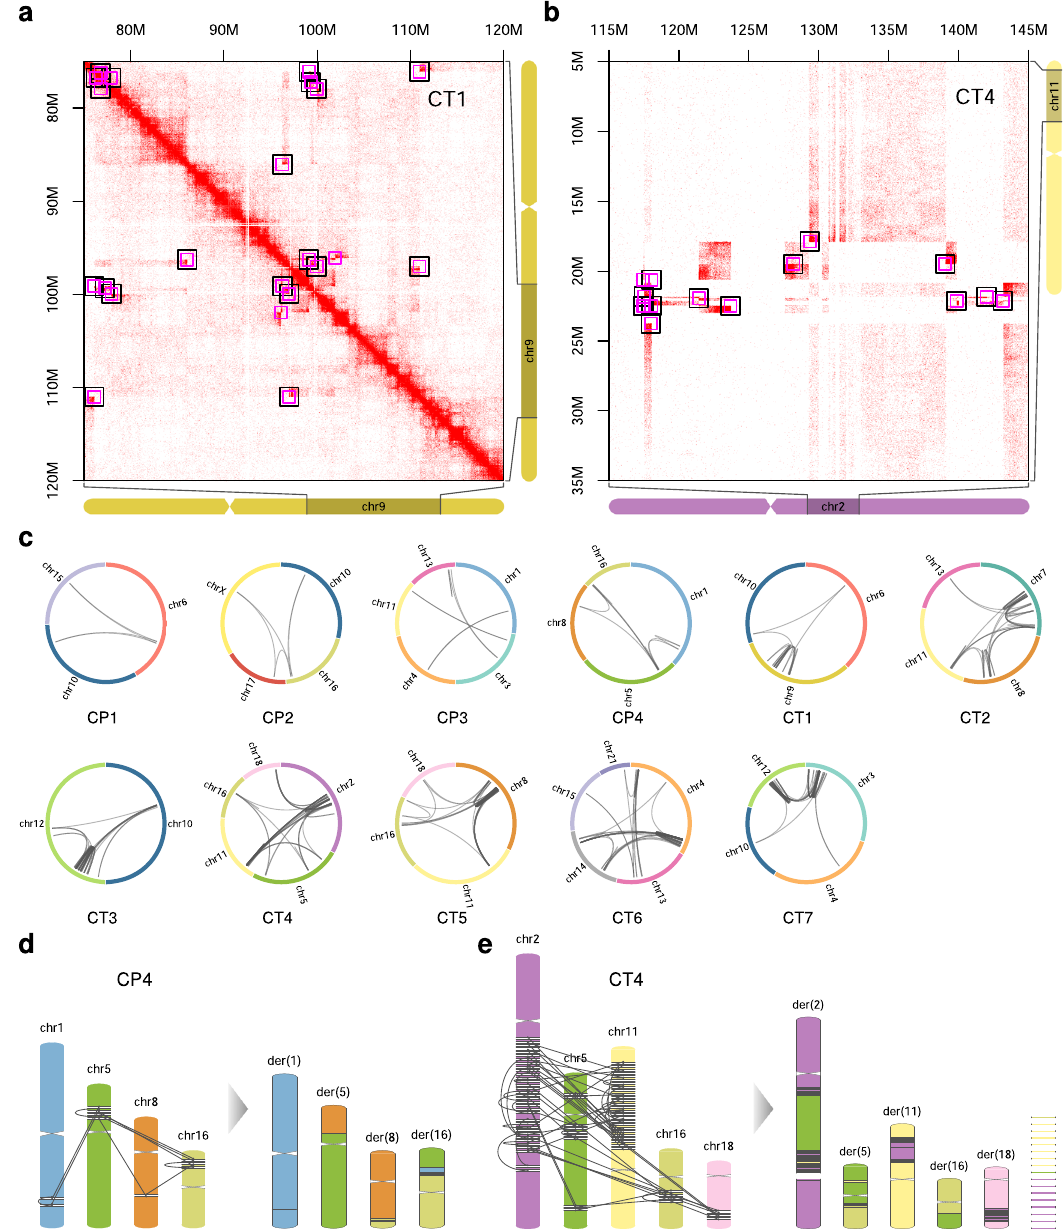
Fig. 2 | Reconstruction ofshatteredchromosomes.a Overlay ofcurated SVcalls fromIlluminaGS(pinksquares)andPacBioGS(blacksquares)foracisHi-Cmapas well as for b a trans Hi-C map. c Circos plots for 11 samples showing all curated large-scalenoveladjacencies. d Reconstructiongraphandderivativechromosomes forCP4.Thechromosomereconstructionstrategycomprisesseveralstepsstarting with (i) the placement of all curated breakpoints to generate chromosomal